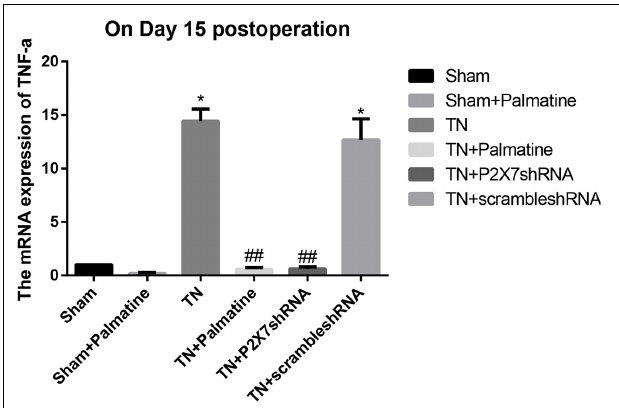
FIGURE 4 | TNF- α mRNA expression in TGs of each group detected by qRT-PCR on 15 days after operation. Values are mean ± SD, n = 6, * p < 0.05 vs. sham group, ## p < 0.01 vs. TN